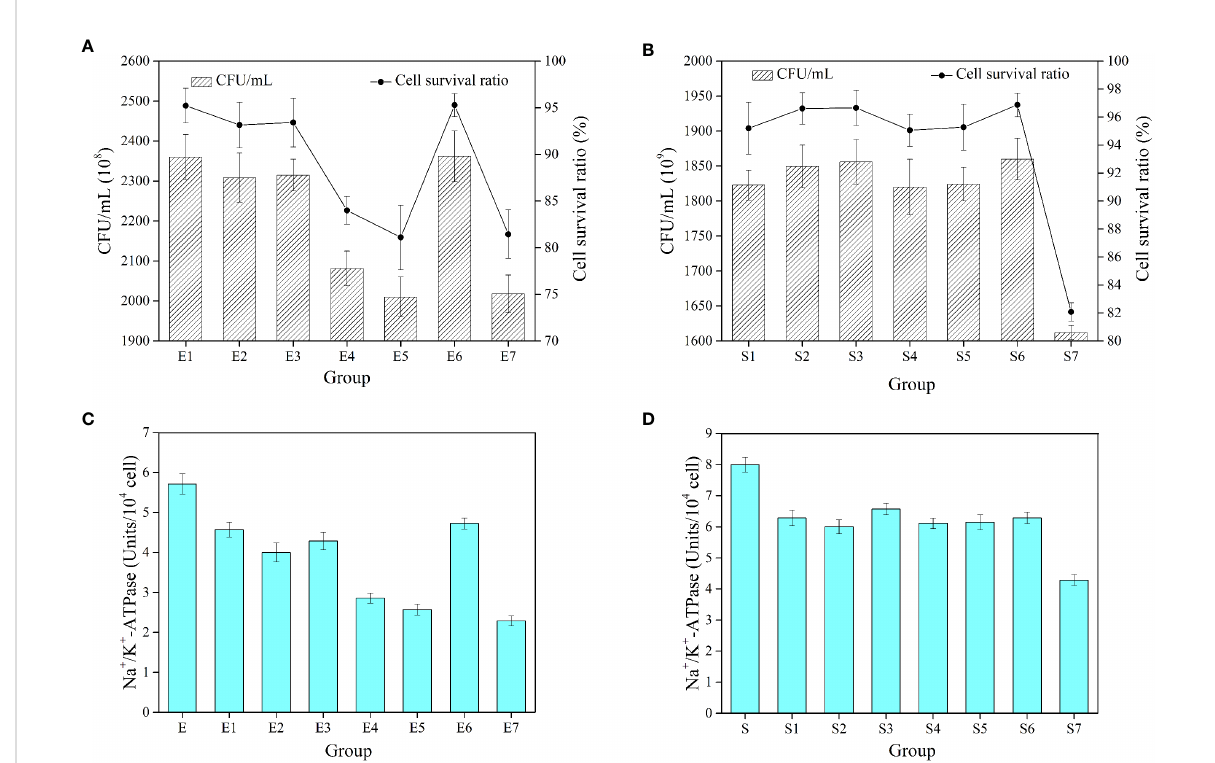
FIGURE 9 The number of cells and cell survival ratio of E coli (A) . The number of cells and cell survival ratio of S. aureus (B) . Na + /K + -ATPase activity in E coli after different treatments (C) . Na + /K + -ATPase activity in S. aureus after different treatments (D) . E represents the unfrozen E coli . E1-E7 represent E coli supplemented with BPS (0.5, 1.0, 1.5, 2.0 and 2.5%, w/v), 20% glycerol, sterile water and then frozen for 7 d. S represents the unfrozen S. aureus . S1-S7 represent S. aureus supplemented with BPS (0.5, 1.0, 1.5, 2.0 and 2.5%, w/v), 20% glycerol, sterile water and then frozen for 7 d. All values are mean values (n =